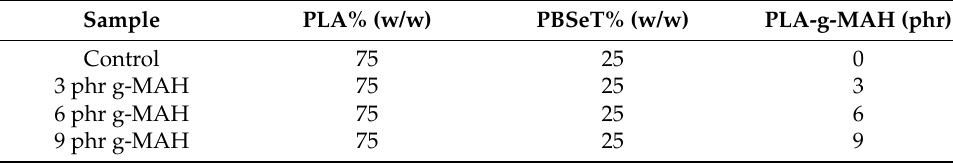
Table 5. Compositions of PLA/PBSeT/PLA-g-MAH